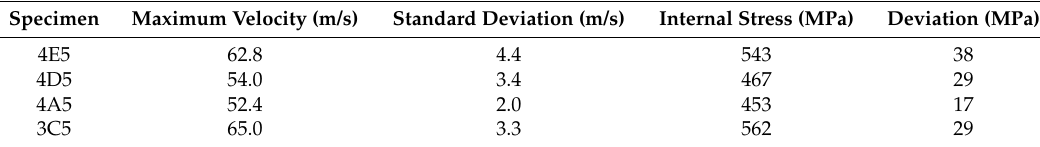
Table 3. Maximum velocities are converted into estimates for the threshold interface debond strength for the variable bond strength fuel plate specimens produced by LANL.